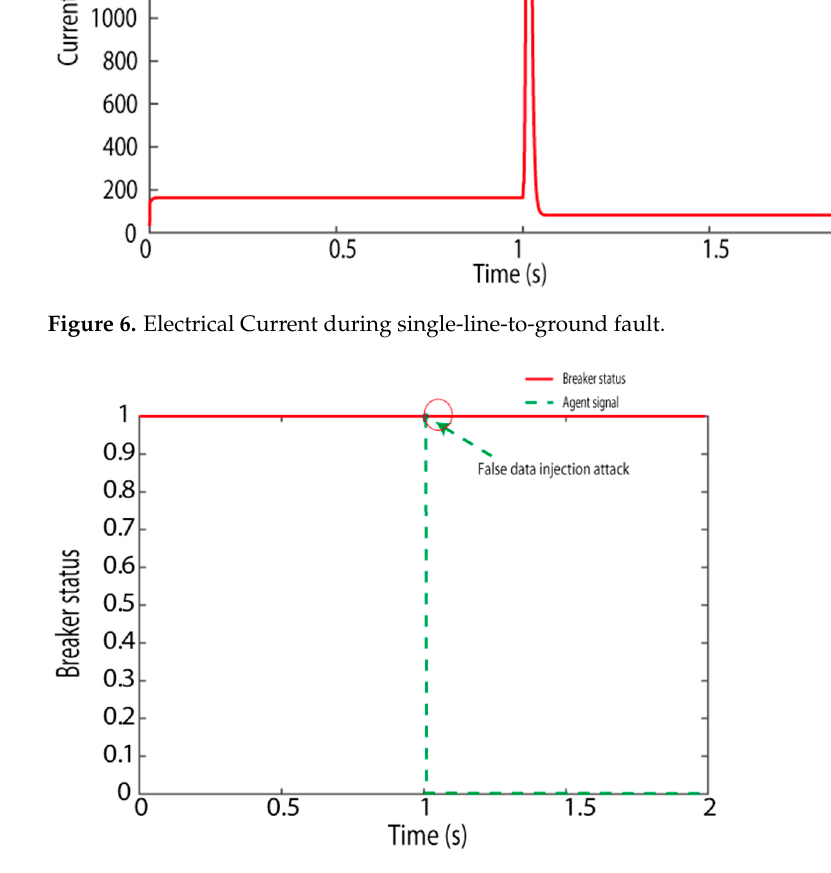
Figure 7. Breaker status for CB5 during cyber-attack.